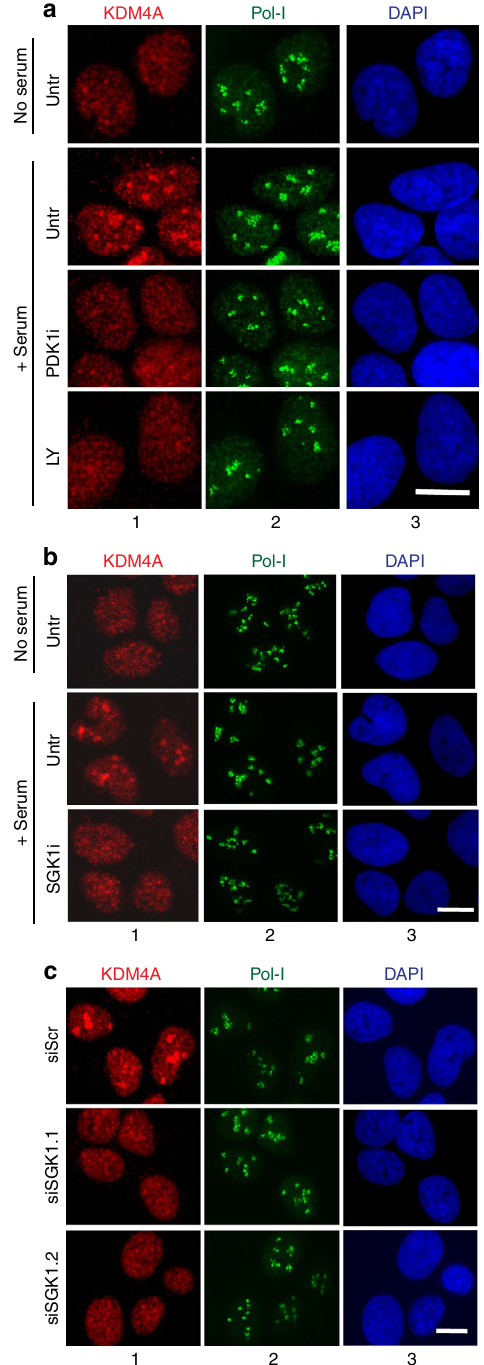
Figure 8 | PI3K/SGK1 signalling cascade controls nucleolar localization of KDM4A. ( a ) U2OS cells were serum starved for 24h. Starved cells were incubated for 30min with PDK1 inhibitor GSK2334470 (PDK1i), or PI3K inhibitor LY294002 (LY) or DMSO as a control (Untr) and refed with serum in the presence of 5-FUrd and the respective inhibitors ( þ serum) or left starved (no serum). Thirty minutes after serum addition cells were fixed and analysed by indirect immunofluorescence using antibodies specific to human KDM4A (panels 1) and Pol-I (panels 2); nuclear DNA was stained by DAPI (panels 3). Scale bar, 5 m M. ( b ) U2OS cells were serum starved for 24h. Starved cells were incubated for 30min with SGK1 inhibitor GSK650394 (SGK1i), or DMSO as a control (Untr) and refed with serum in the presence of 5-FUrd and inhibitor ( þ serum) or left starved (no